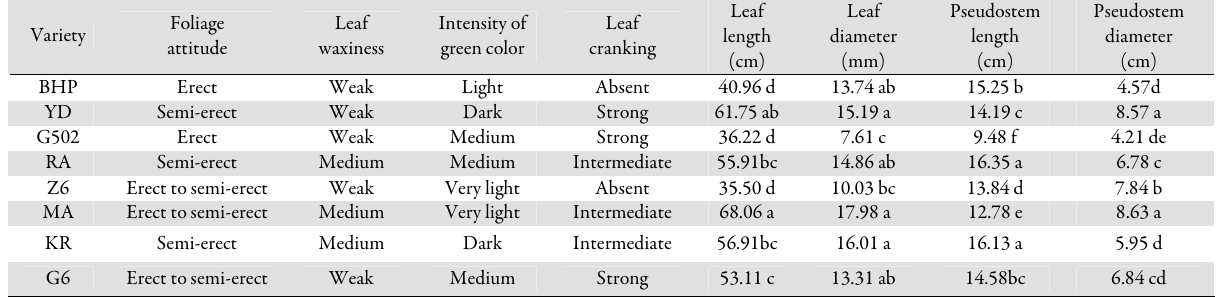
Tab. 1. Foliage characteristics of eight varieties of onion cultivated under temperate conditions of Tunisian Variety